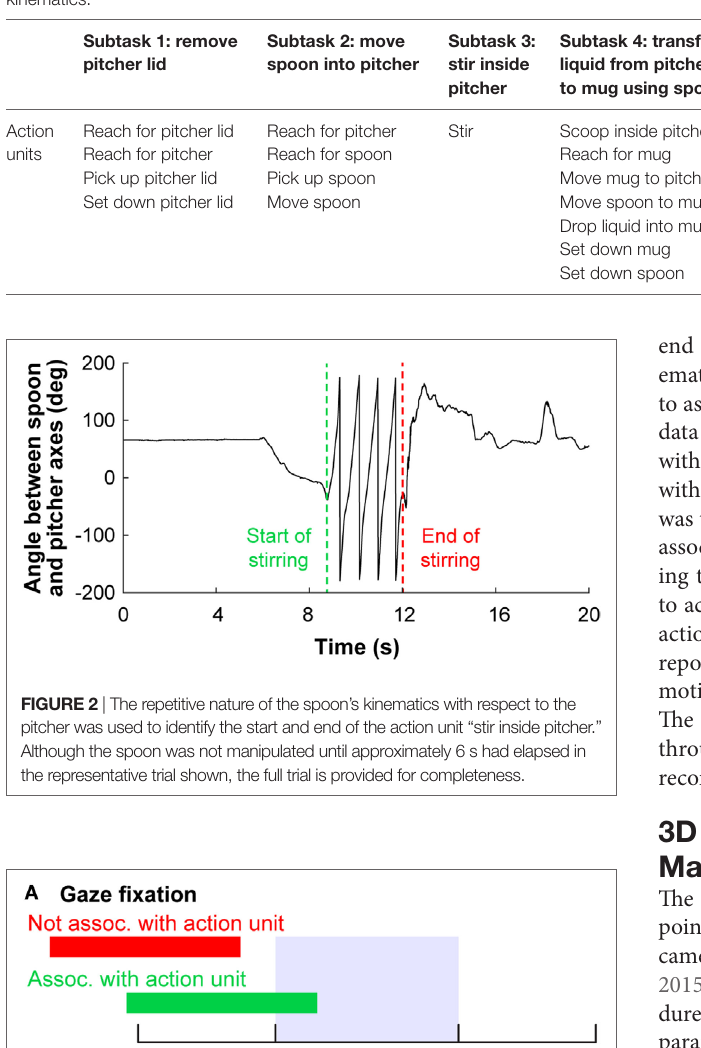
TaBle 1 | Six subtasks (bold) were defined for the task of making a powdered drink; action units were defined for each subtask according to hand and object